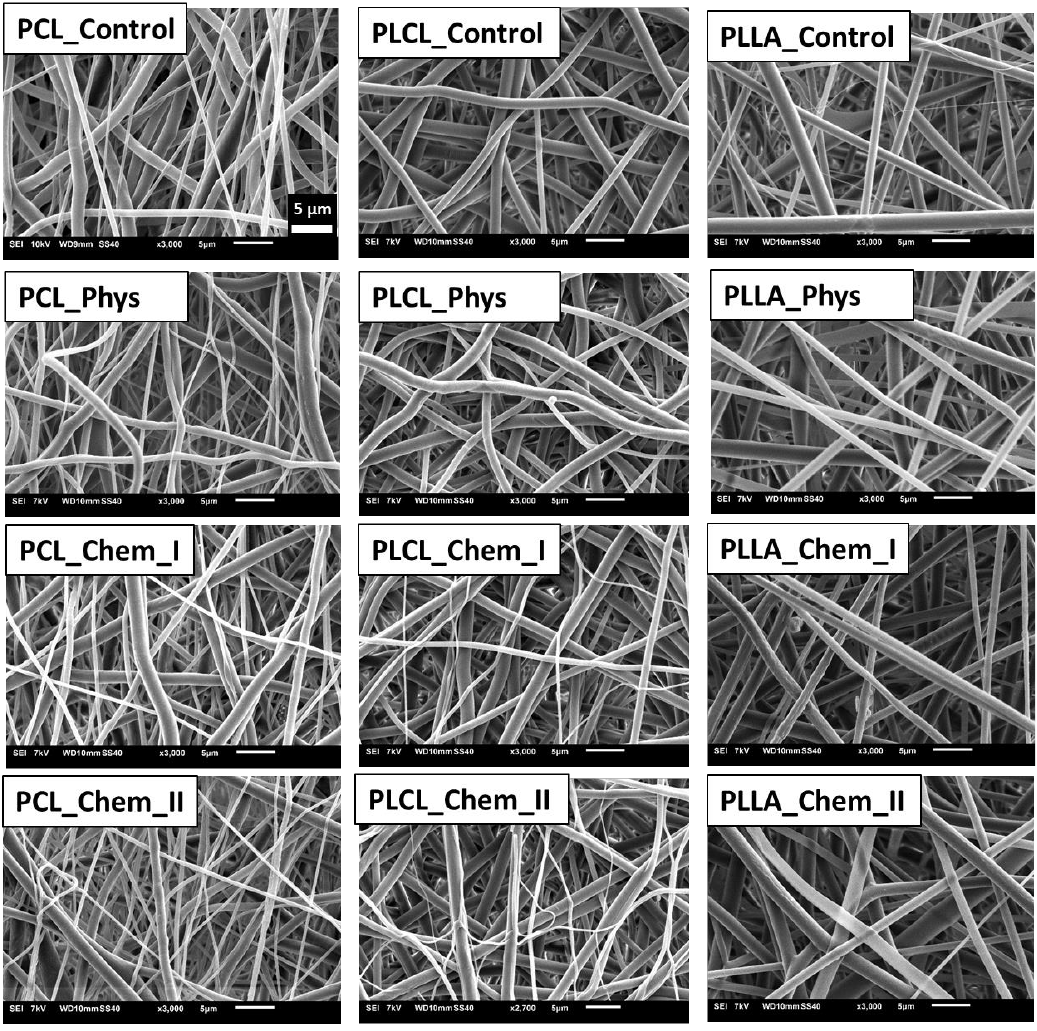
Figure 1. Morphology of controls and samples subjected to physisorption and chemical immobilization of gelatin.